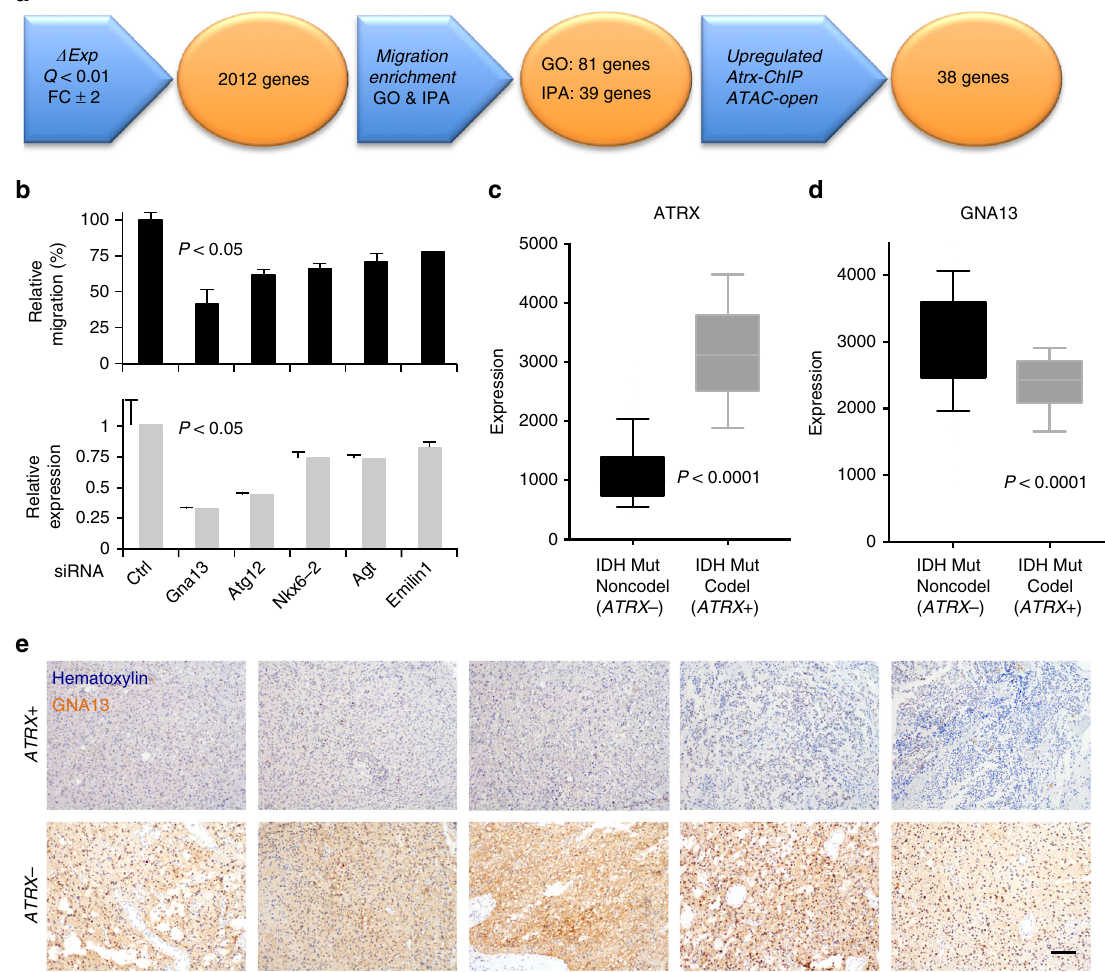
Fig. 6 Gna13 promotes cell migration in Atrx - mNPCs and is upregulated in ATRX-de fi cient gliomas. a schematic demonstrating strategy to identify upregulated genes promoting mNPC motility in the setting of Atrx de fi ciency (FC: fold change). b relative mNPC transwell migration (upper chart) following siRNA knockdown (25 nM) of the indicated gene target (lower panel), as con fi rmed by RT-qPCR (error bars re fl ect standard deviation; P values determined by unpaired two-tailed t -test). c , d LGG expression data from TCGA showing levels of ATRX and GNA13 expression in ATRX-intact ( ATRX + ) and ATRX-de fi cient ( ATRX -) gliomas. Error bars re fl ect the 10 – 90 percentile spread and P values determined by unpaired two-tailed t -test. e micrographs of ATRX + and ATRX - gliomas showing differential GNA13 expression by IHC (hematoxylin counterstain; scale bar 100 µ